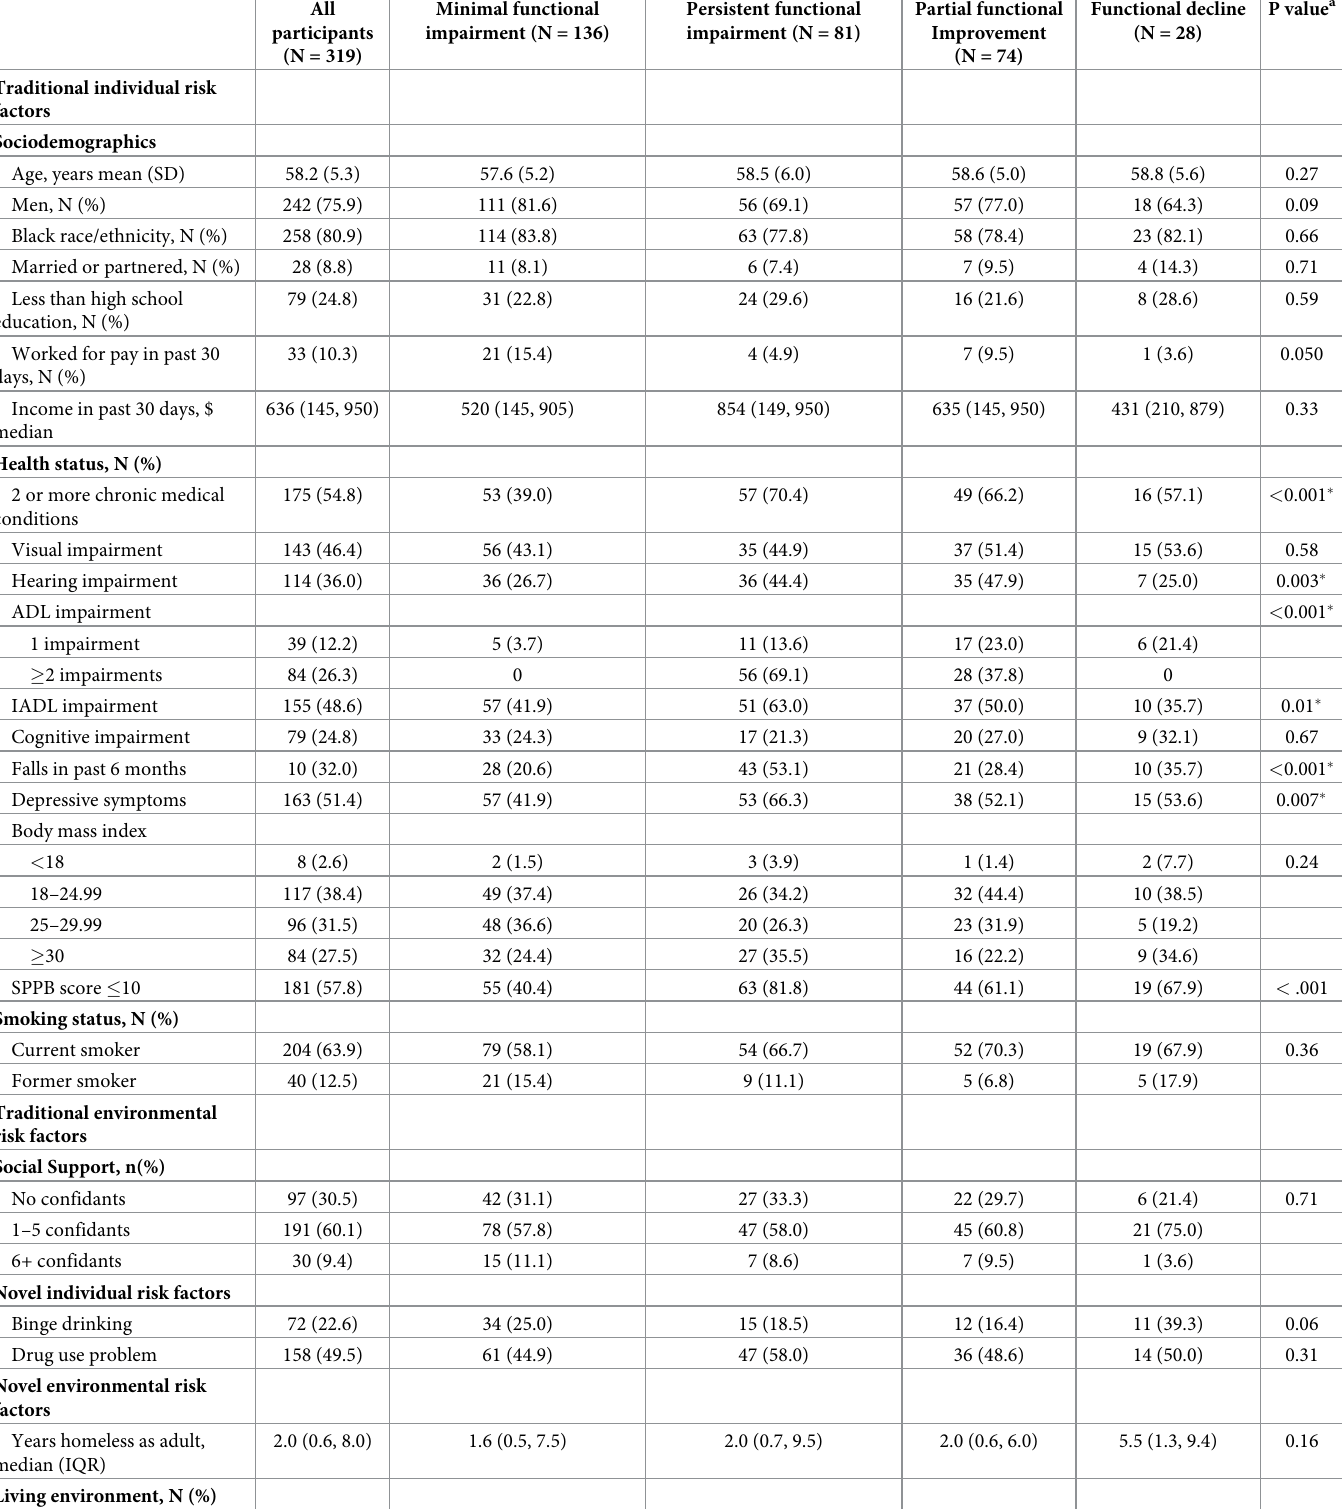
Table 1. Baseline characteristics of 319 homeless participants by functional